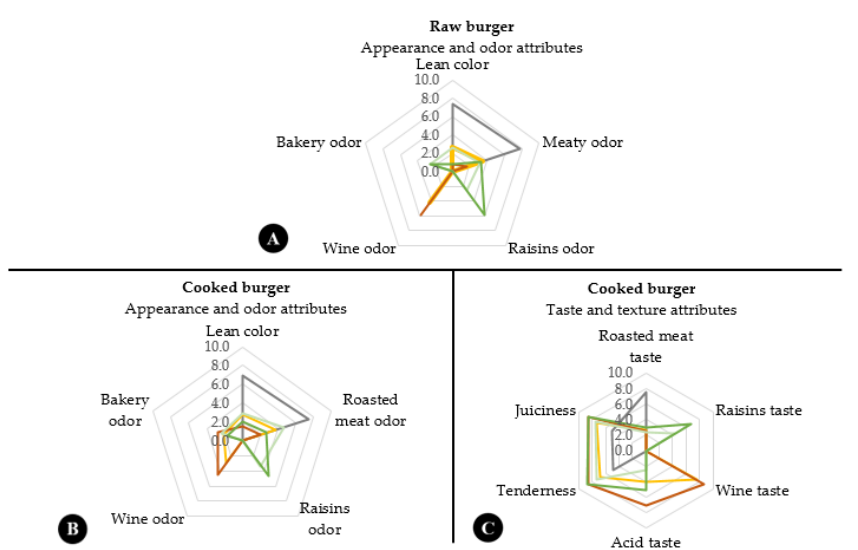
Figure 4. Quantitative descriptive analysis of raw and cooked venison burgers. Symbols: